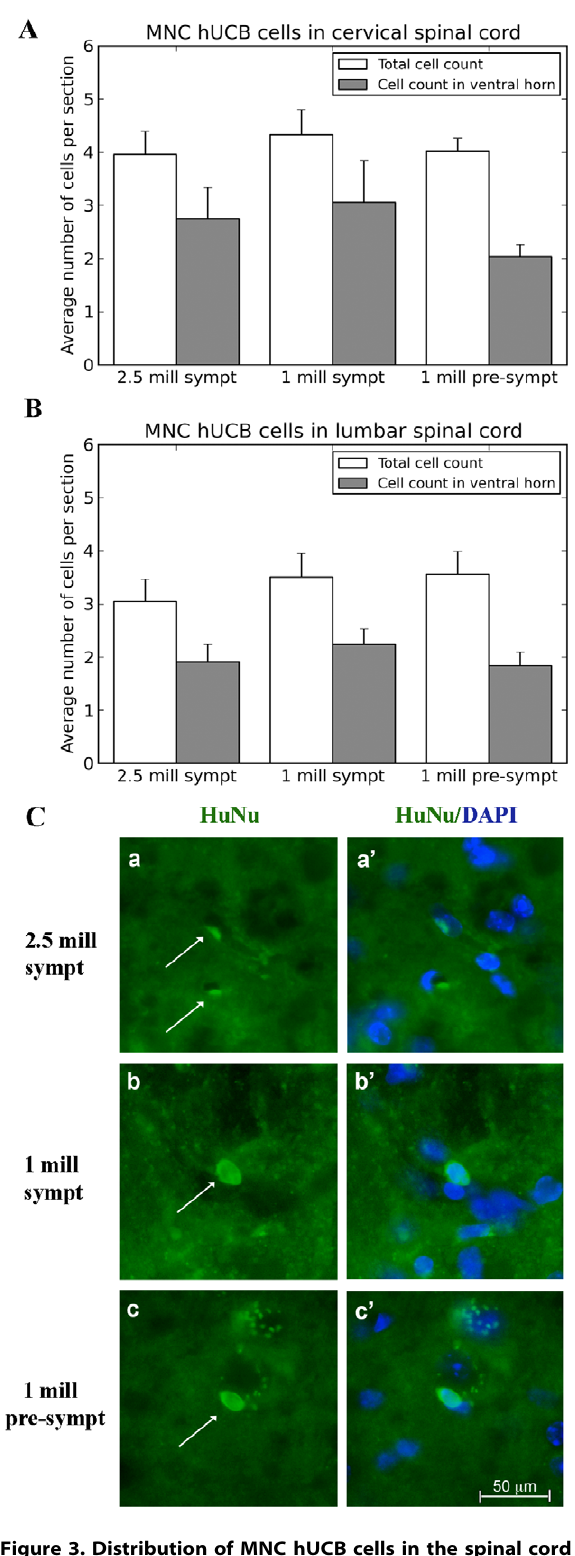
Figure 3. Distribution of MNC hUCB cells in the spinal cord of G93A mice. Administered MNC hUCB cells were identified immuno- histochemically by a human-specific marker (HuNu) in the spinal cord of cell-treated mice at 17 weeks of age, 4 weeks (symptomatic) or 8 weeks (pre-symptomatic) post-transplant. In the total area of cervical ( A ) and lumbar ( B ) cervical spinal cord, HuNu positive MNC hUCB cells were found irrespective (p . 0.05) of injected cell doses or time beginning